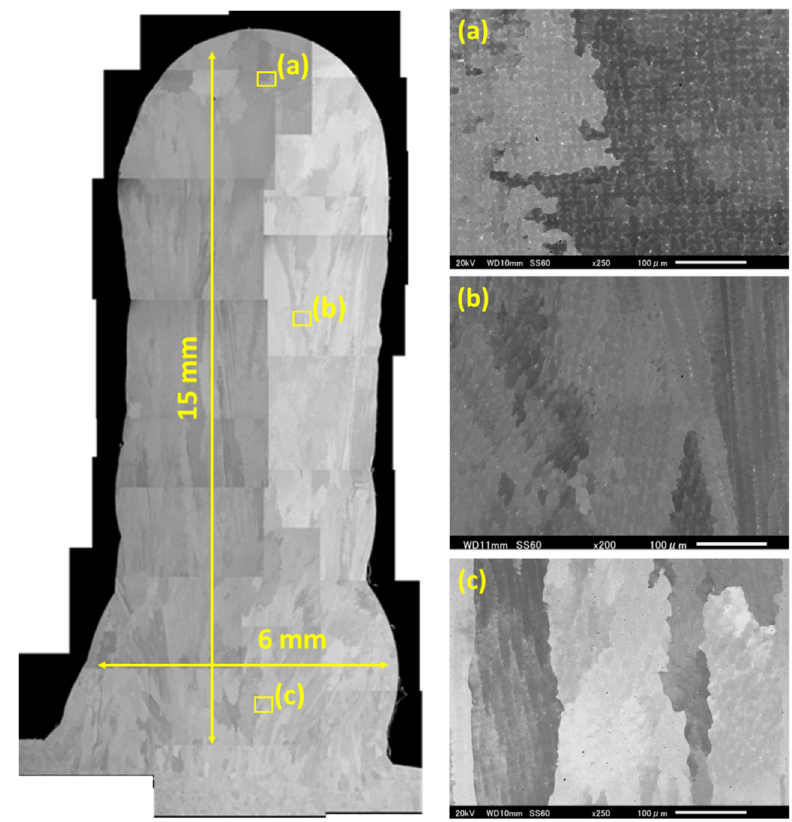
Figure 6. Solidification microstructure of the WAAM process under the conditions in Table 1 and Figure 1, at ( a ) p10, ( b ) p5, and ( c ) p1. MPFM microstructure evolution analyses for the condition of the tenth layer position Table 4. Conditions of MPFM calculation under the conditions of the tenth layer position (p10) in Table 3 were performed. Physical and numerical conditions are shown in Table 4.